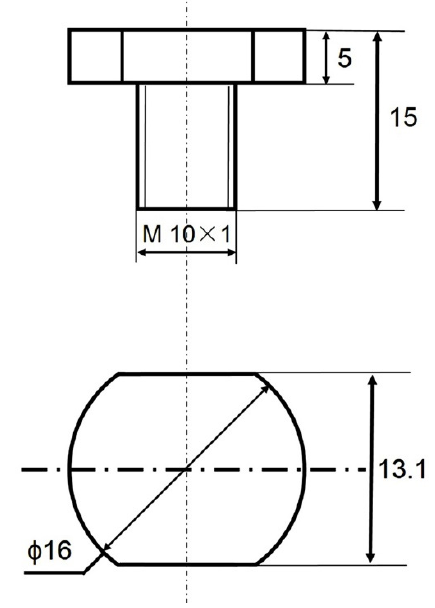
Figure 1. Dimensions of CE samples (unit: mm).